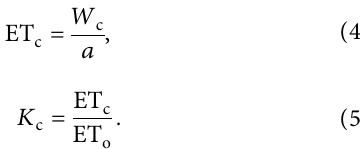
Figure 4: A total of 33 samples of pagoda mustard